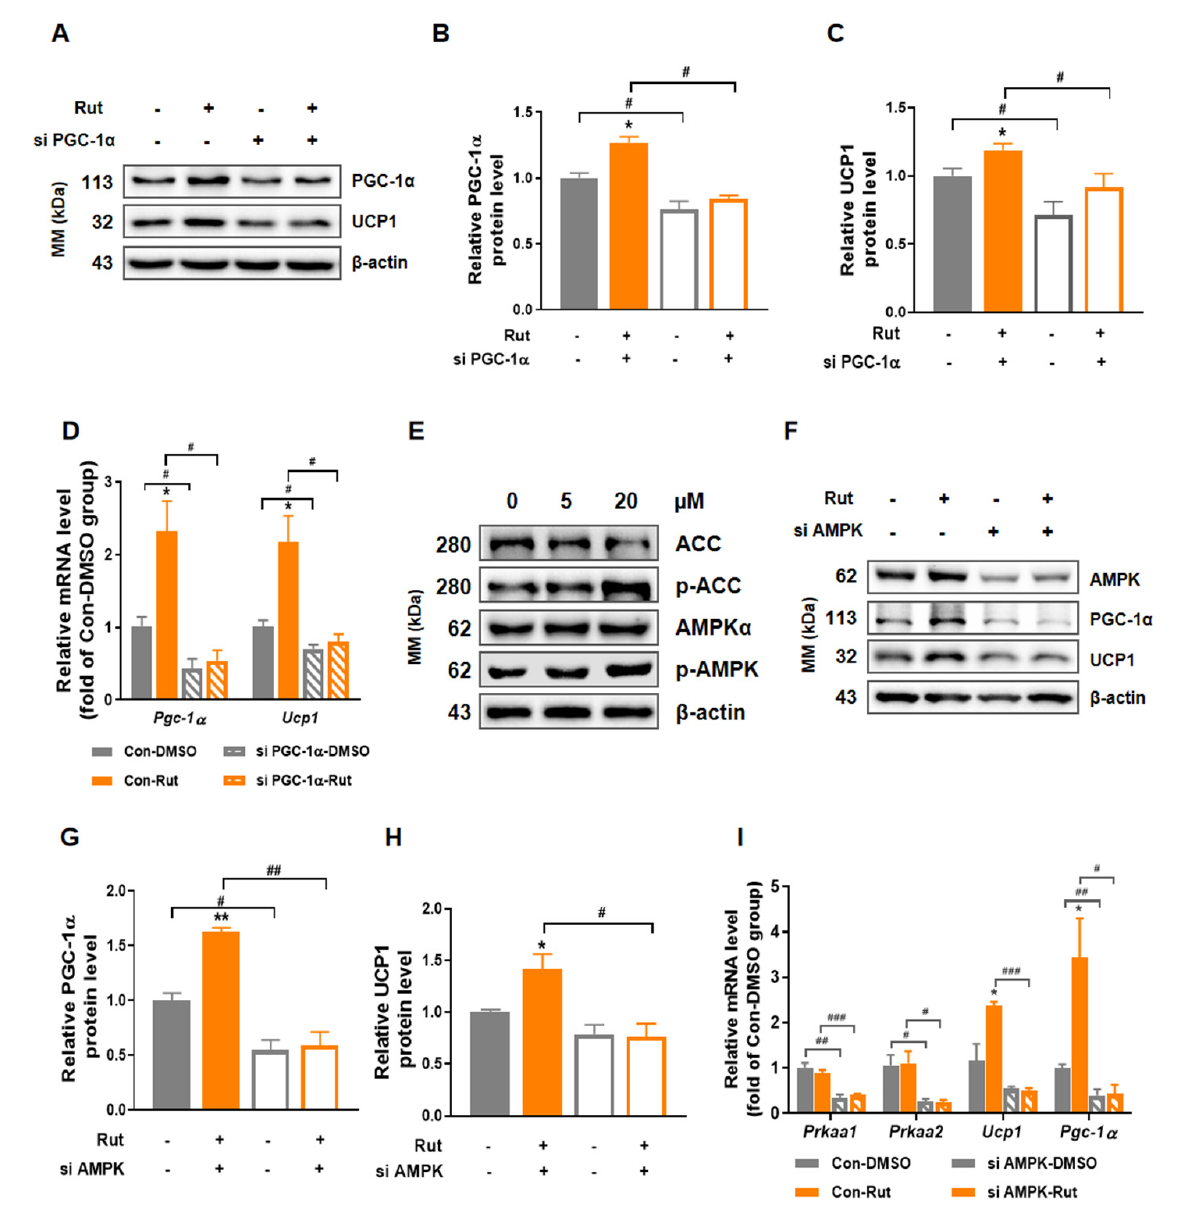
Figure 6. Rut stimulates thermogenic program via AMPK/PGC-1 α pathway. ( A ) Expression of PGC-1 α and UCP1 protein by siRNA against PGC-1 α . ( B , C ) Relative protein level of PGC-1 α ( B ) and UCP1 ( C ) compared to β -actin. ( D ) The mRNA level of Pgc-1 α and Ucp1 after blockage of PGC-1 α . ( E ) Expression of p-AMPK, AMPK, p-ACC and ACC protein in C3H10-T1/2 treated by Rut. ( F ) Ex- pression of PGC-1 α and UCP1 protein in C3H10-T1/2 with siRNA against AMPK and Rut treatment. ( G , H ) Relative protein level of PGC-1 α ( G ) and UCP1 ( H ) compared to β -actin. ( I ) The mRNA level of Pgc-1 α and Ucp1 after silence of AMPK. n = 3 per group. Data are presented as the means ±SEM. * p < 0.05, ** p < 0.01, Rut group versus vehicle group; # p < 0.05, ## p < 0.01, ### p < 0.001, siRNA group versus control group by Student’s t -test.